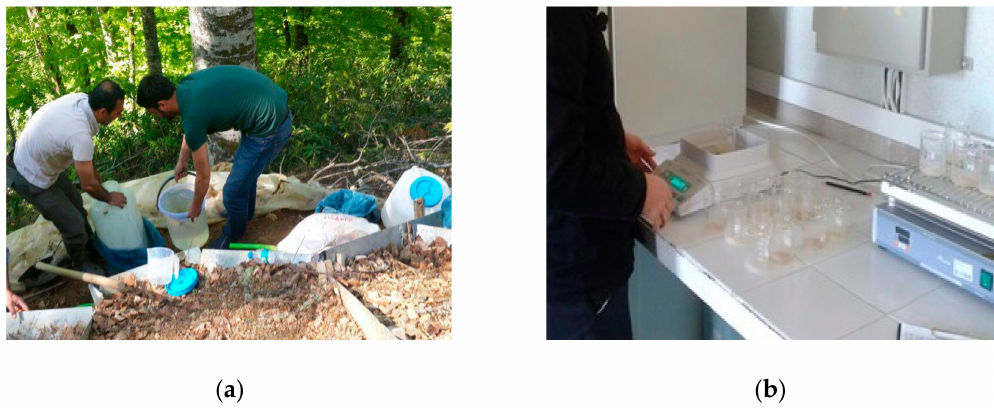
Figure 3. ( a ) Water sample collection; ( b ) water sample analysis at the